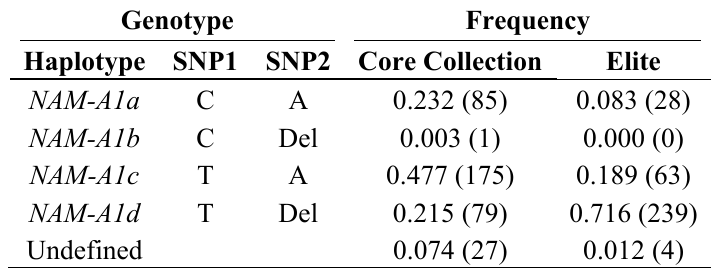
Table 1. No Apical Meristem ( NAM ) -A1 haplotype frequencies in two collections of bread wheat genotypes. Frequency followed by the number of lines (in